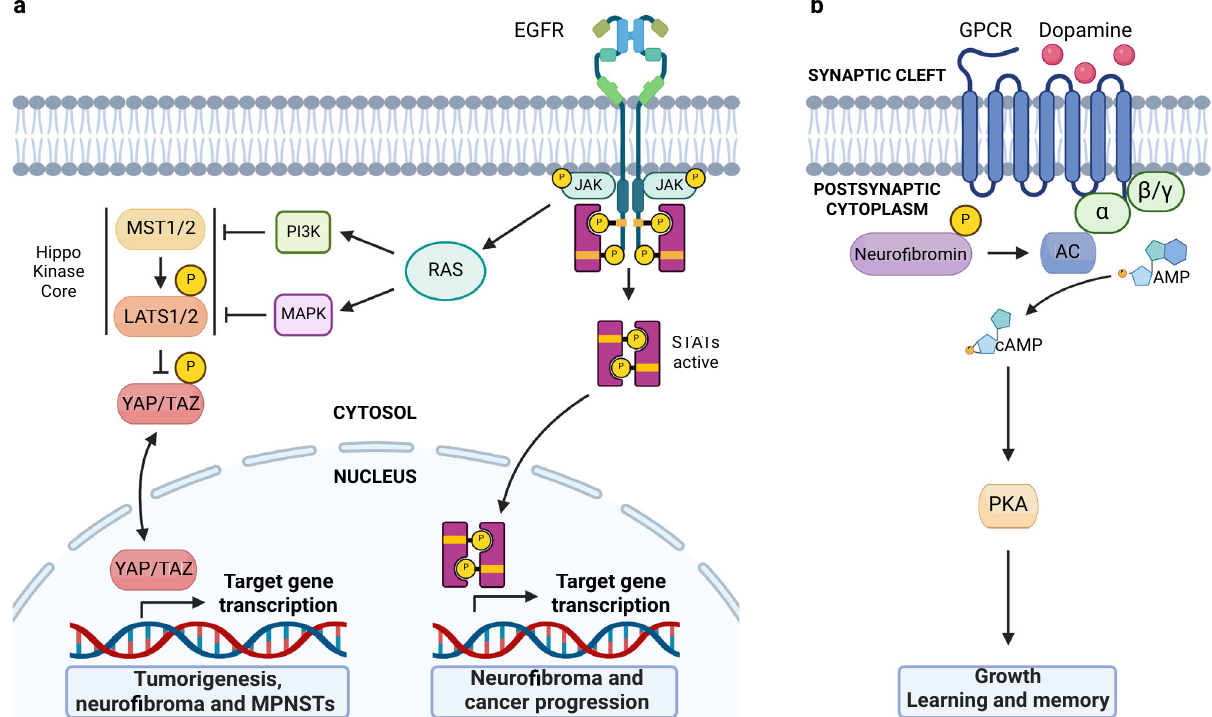
Fig. 4 Hippo, JAK/STAT and dopamine signaling pathways are regulated by neuro fi bromin. a The Hippo pathway is a master regulator of tissue homeostasis and organ size in which MST1/2, LATS1/2 and YAP/TAZ are major players. The JAK/STAT pathway regulates embryonic development and is involved in processes such as stem cell maintenance, hematopoietic and in fl ammatory response. These pathways also regulate gene expression implicated in tumorigenesis and cancer progression. b This pathway involves neuro fi bromin in regulating cAMP levels, important in neuronal connections in which dopamine travels to areas of the brain and body to convey important information such as executive thinking, cognition, feelings of reward and pleasure and voluntary motor movements. Dopamine is thought to guide learning via dynamic and differential modulation of